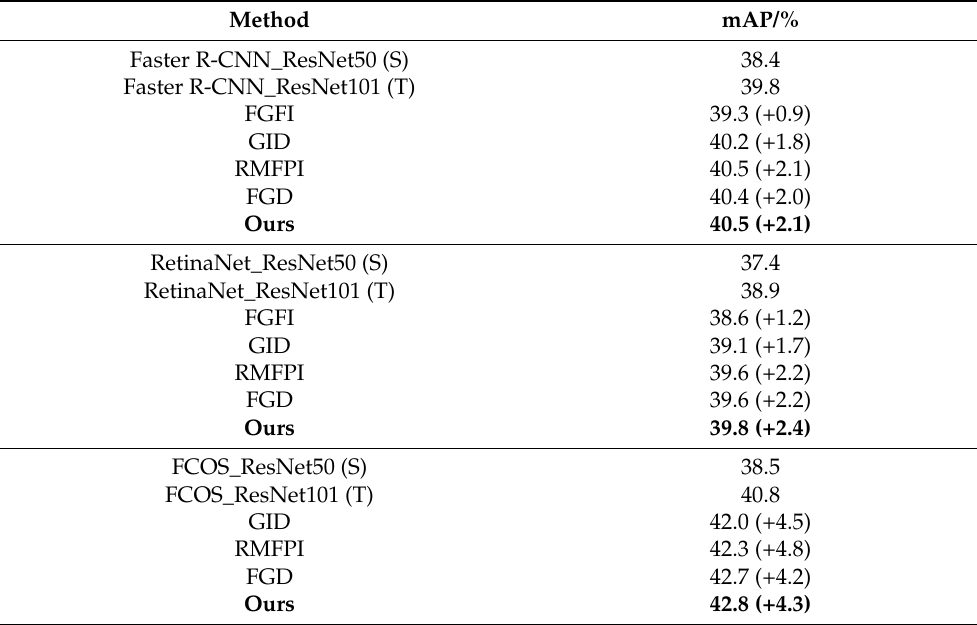
Table 1. Performance comparison between different distillation methods using the COCO2017 dataset. The bold means the best